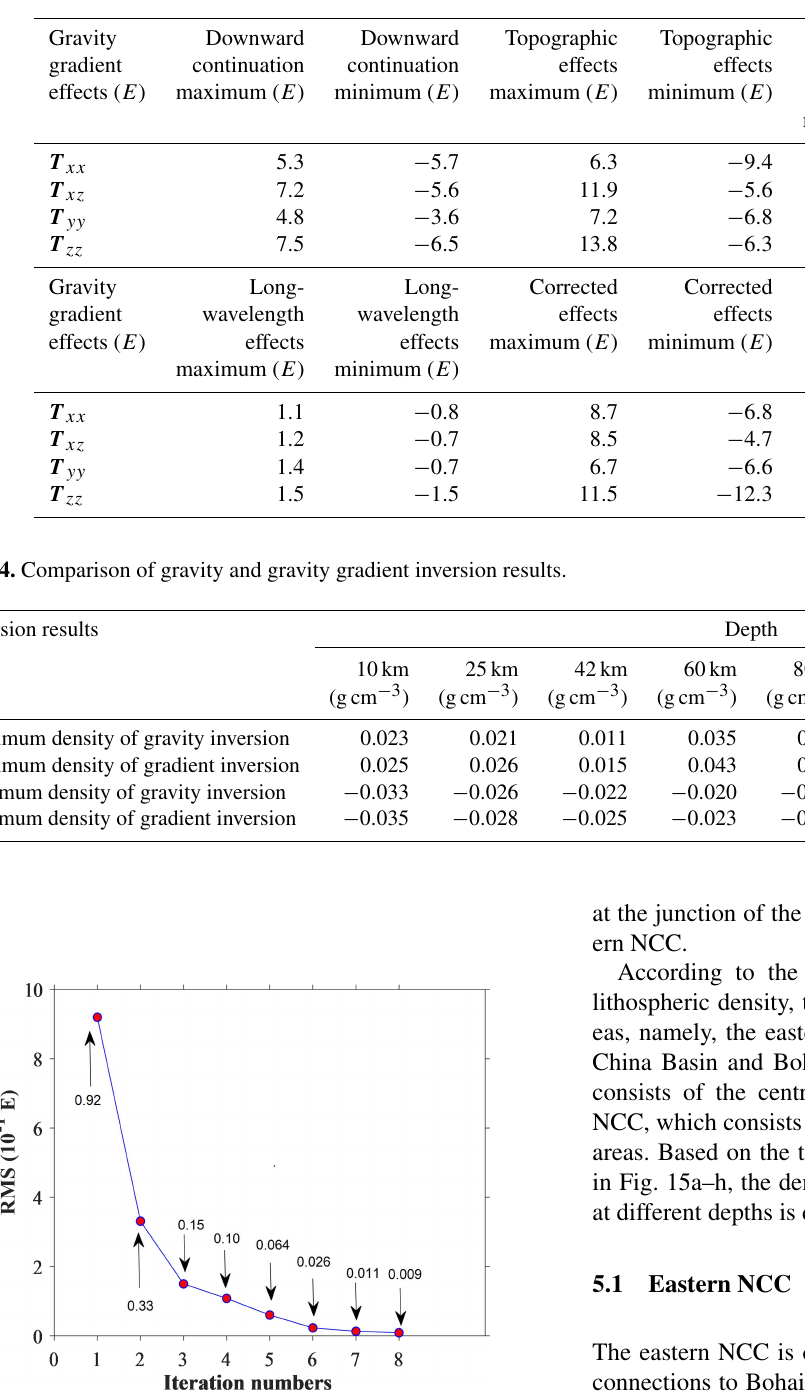
Table 3. Statistics for each gravity gradient correction.